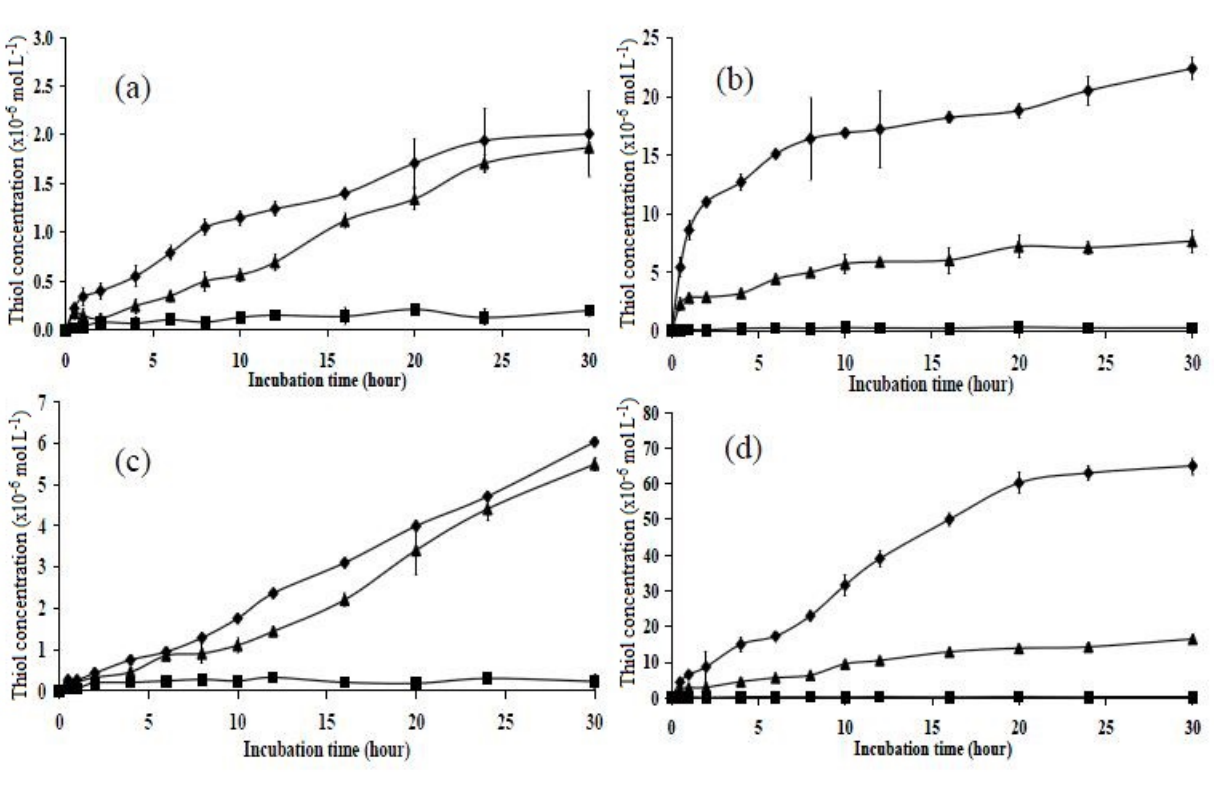
Figure 6. Thiol concentration as a function of incubation time in phosphate buffer medium over a 5 h time period in polymers ( a ) P10; ( b ) P11; ( c ) P151; and ( d ) P15. Mean ± SD, n =